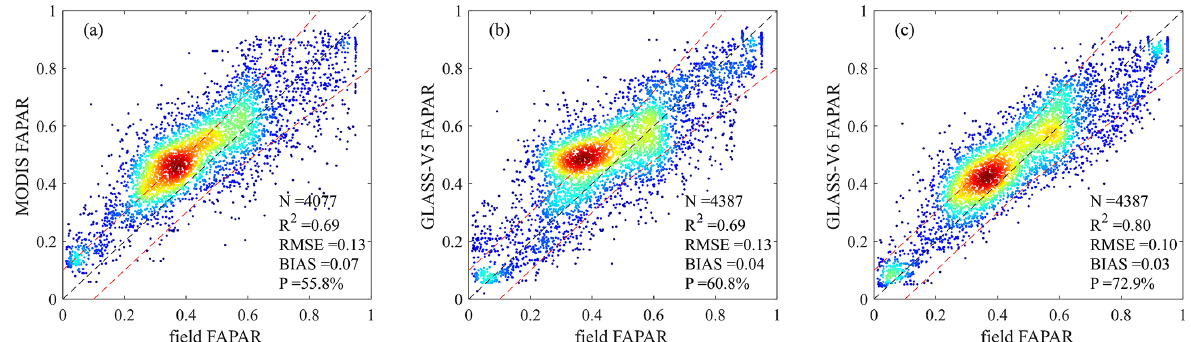
Figure 5. Direct validation of the (a) MODIS, (b) GLASS V5, and (c) GLASS V6 FAPAR products at the 500m scale using 62 upscaled high-resolution FAPAR reference maps from 2000 to 2016 from the Bigfoot, VALERI, and ImagineS